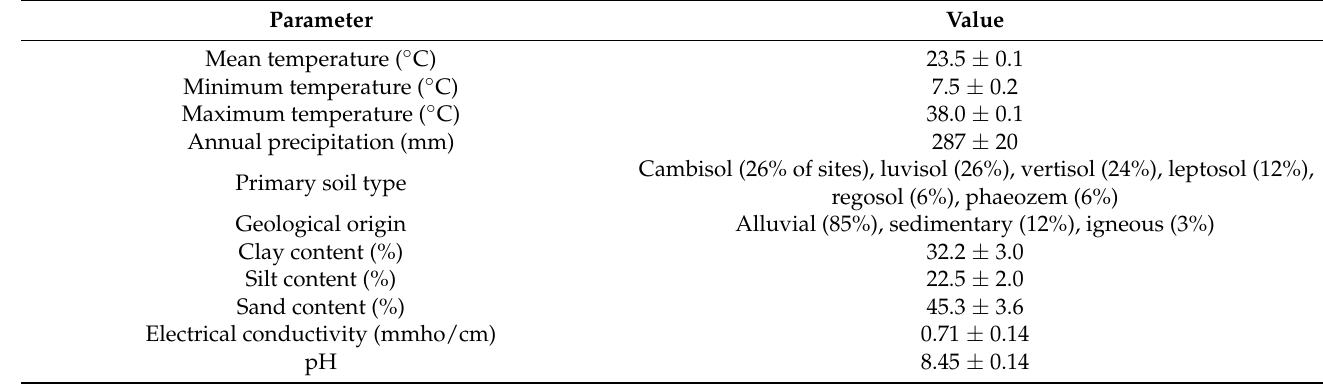
Table 1. Climate and soil attributes from the study region in Sonora, Mexico. Data are means ± 1 S.E. (n = 34 sites).